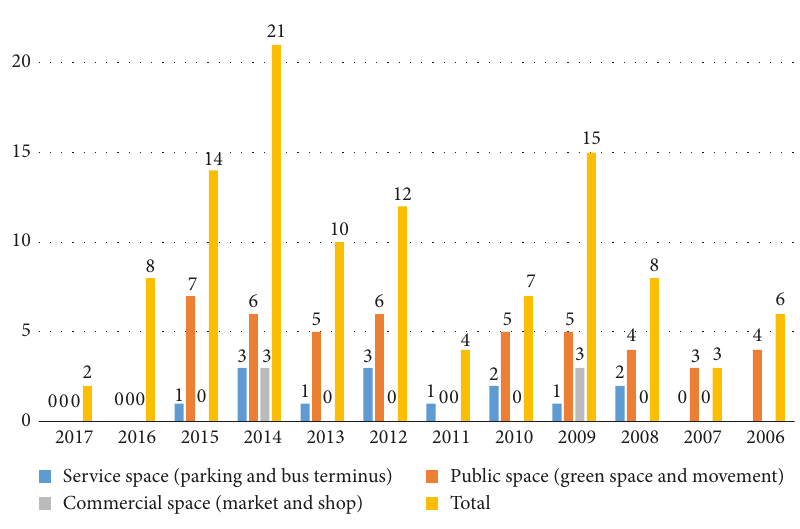
Figure 1: Literature data